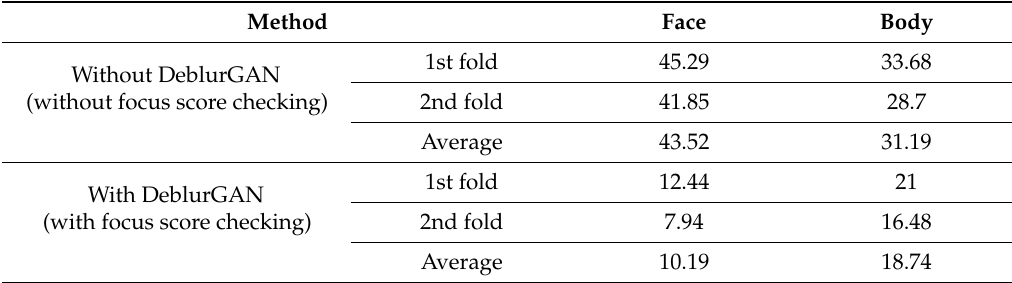
Table 5. Comparison of equal error rate (EER) for face recognition and body recognition on DFB-DB2 without or with DeblurGAN (unit: %).